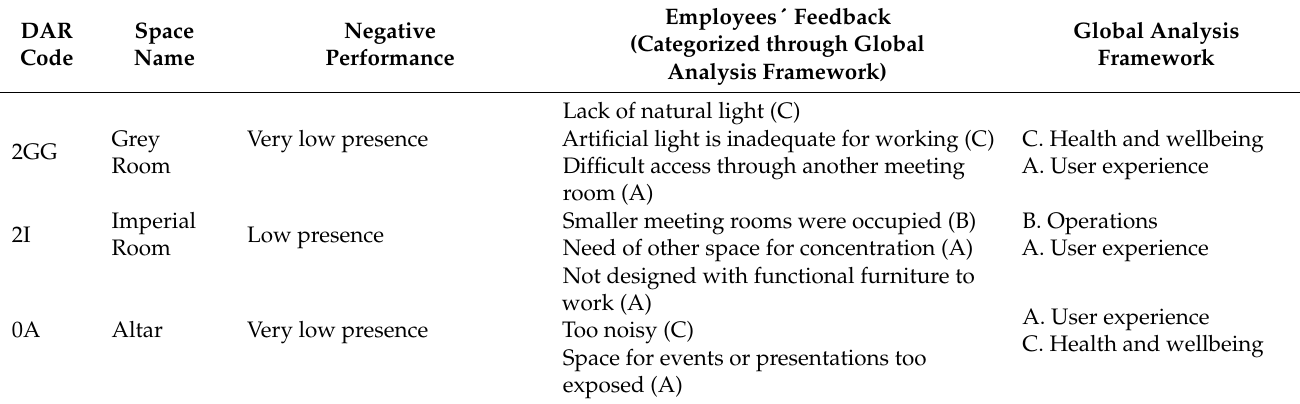
Table 5. Spaces with negative performance and relevant employee